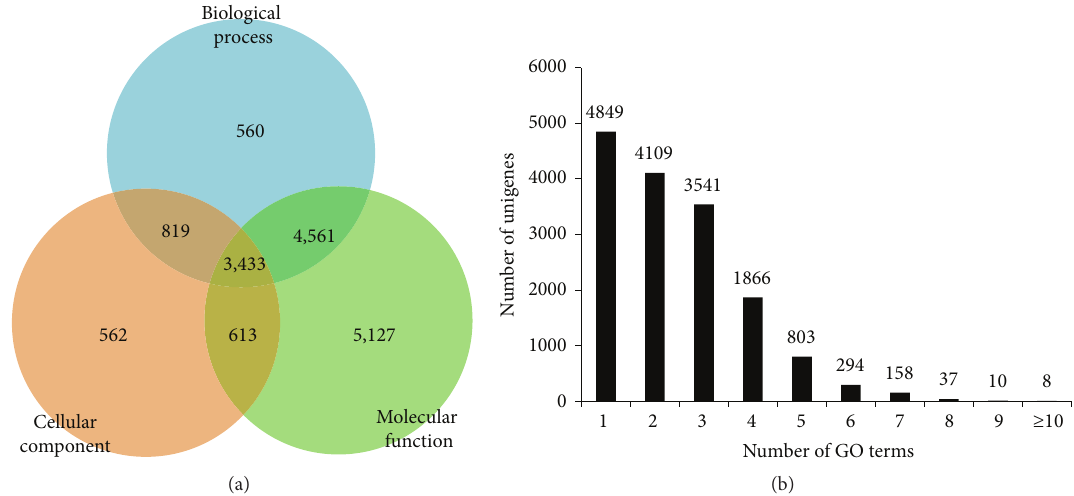
Figure 5: The GO term classification for V. mandarinia unigenes. (a) The three-way Venn diagram analysis of unigenes classified into biological process, cellular component, and molecular function categories. (b) The number of unigenes assigned to the number of GO term annotations.